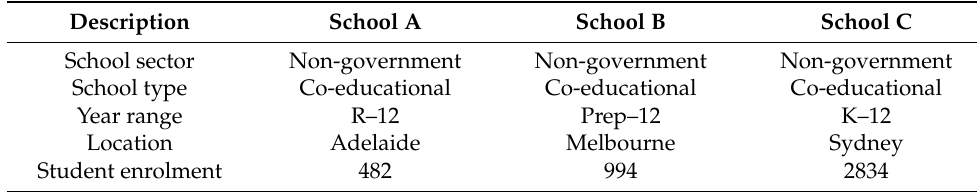
Table 1. Participating schools (2020).